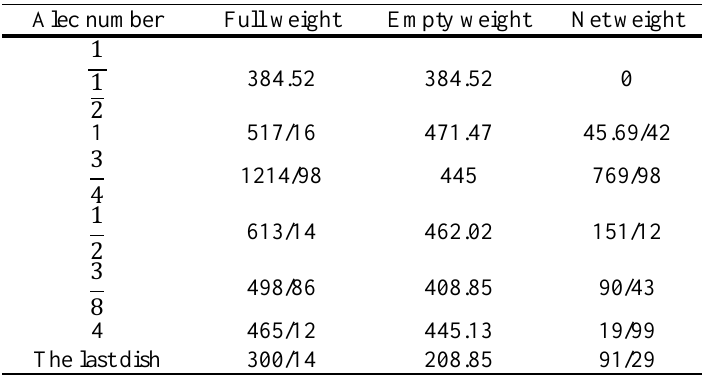
Table 7. Grading table of recycled aggregates.